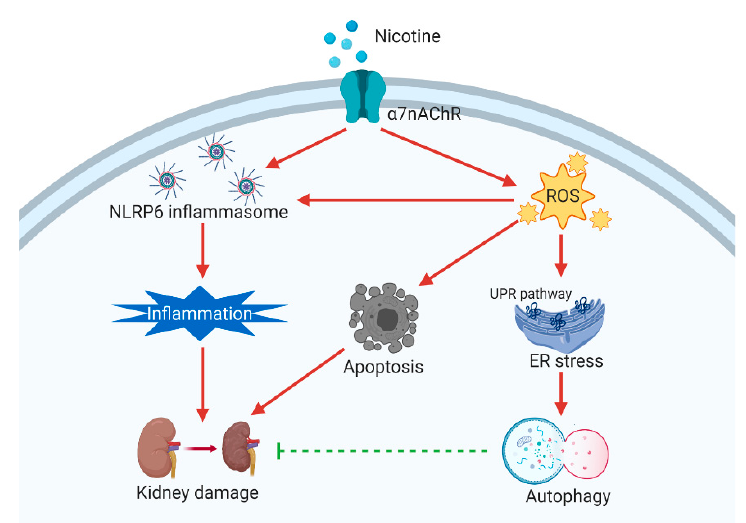
Figure 8. Nicotine causes α 7nAChR, NLRP6 inflammasome, ER stress and autophagy in kidney cells. Nicotine induces the NLRP6 inflammasome via α 7nAChR. Then, the NLRP6 inflammasome causes inflammation and induces kidney damage. Nicotine triggers autophagy through α 7nAChR, and autophagy may protect against nicotine-induced kidney injury. Furthermore, nicotine increases ROS generation and accelerates ER stress by unfolded protein response (UPR) pathways. The high concentration of nicotine can induce apoptosis. Therefore, nicotine causes kidney damage through the modulation of α 7nAChR, NLRP6 inflammasome, ER stress and autophagy. The figure was created with BioRender.com.